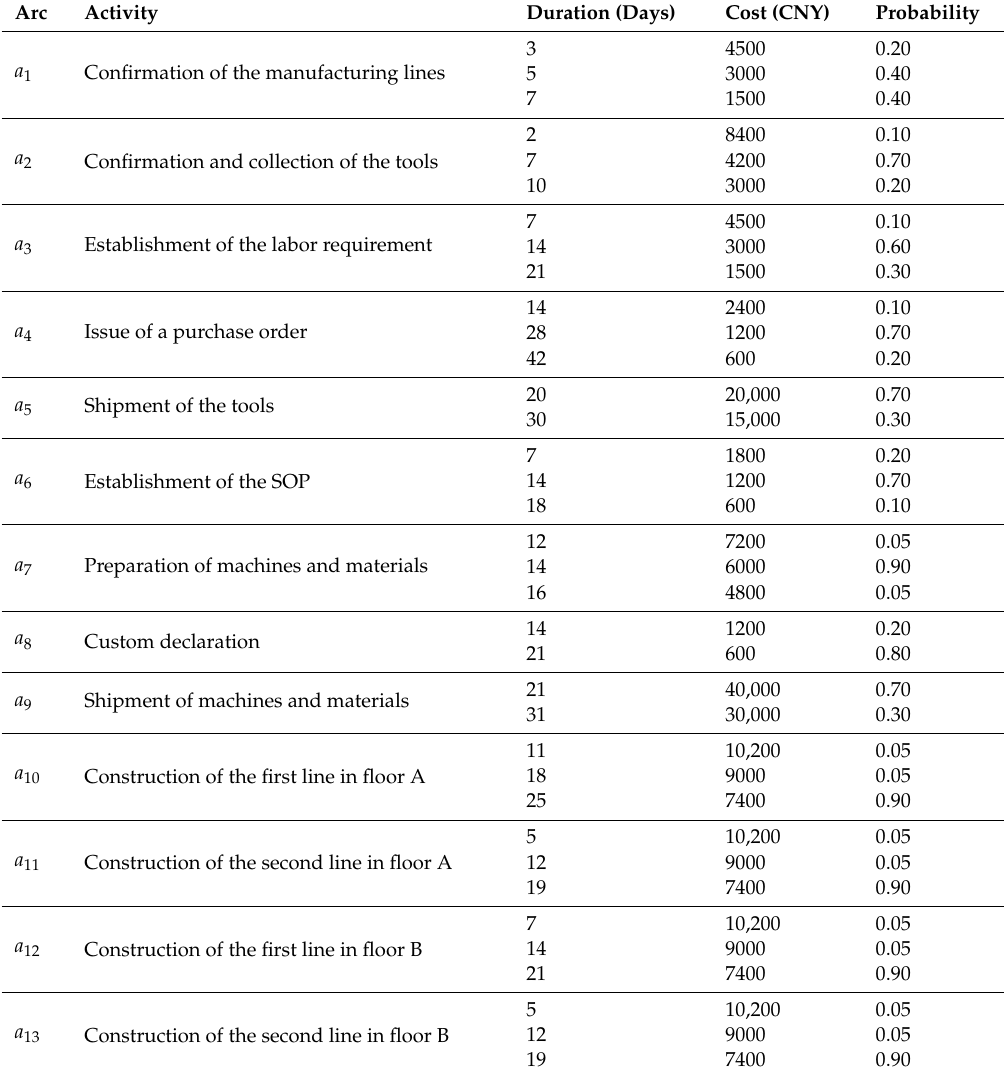
Table 2. Durations, costs, and probabilities of each